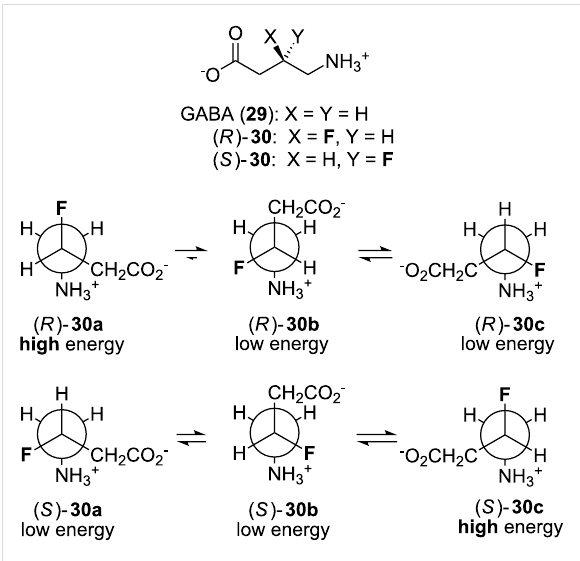
Figure 6: The neurotransmitter GABA ( 29 ) and fluorinated analogues ( R )- 30 and ( S )- 30 . Newman projections of ( R )- 30 and ( S )- 30 along the